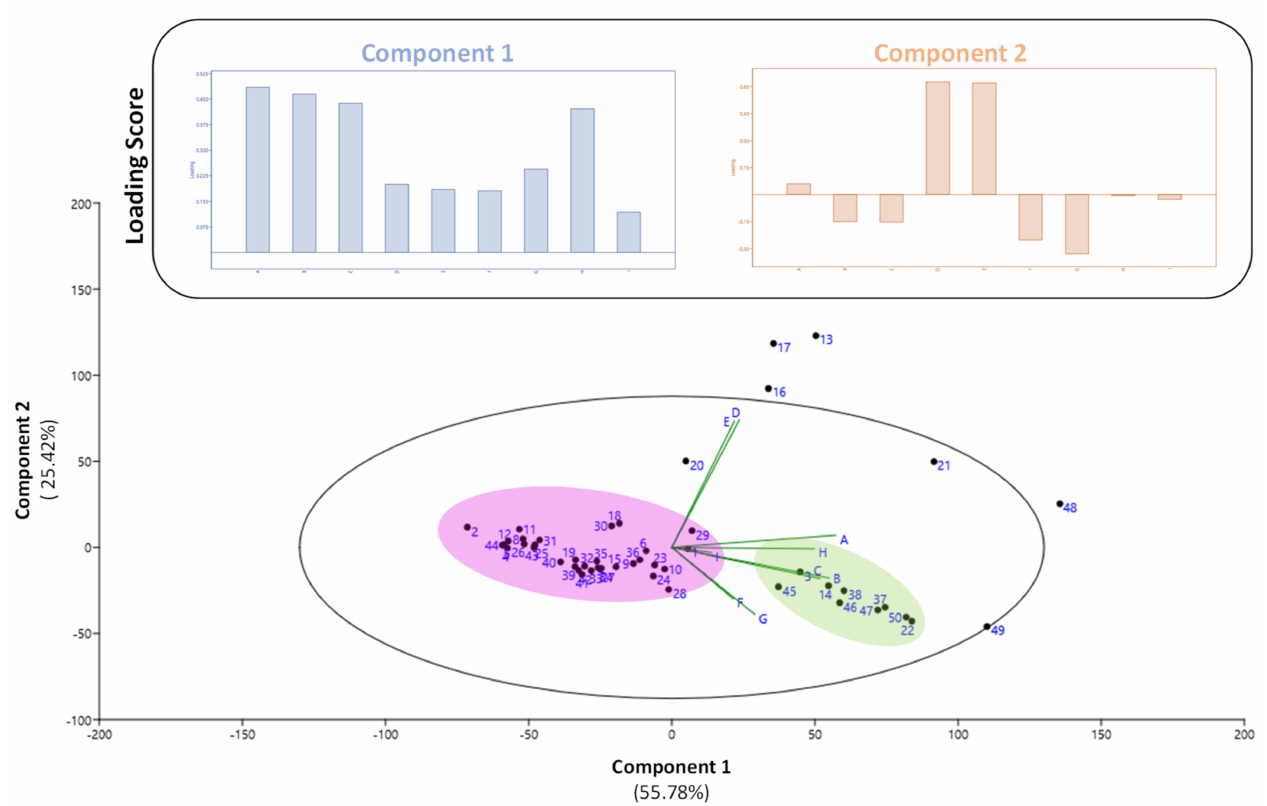
Figure 5. Principal component analysis (PCA) linking the phytochemical profile and (in vitro and cellular) antioxidant capacity of the extracts from 50 Fabaceae populations from Thailand. Variance of component 1 = 55.78% and component = 25.42%. Each number in blue represents the different Fabaceae populations (Figure 1). Letters represent the different phytochemicals and antioxidant assays: A = TPC; B = TFC; C = TAC; D = daidzein content; E = genistein content; F = DPPH assay; G= ABTS assay; H = FRAP assay; I =